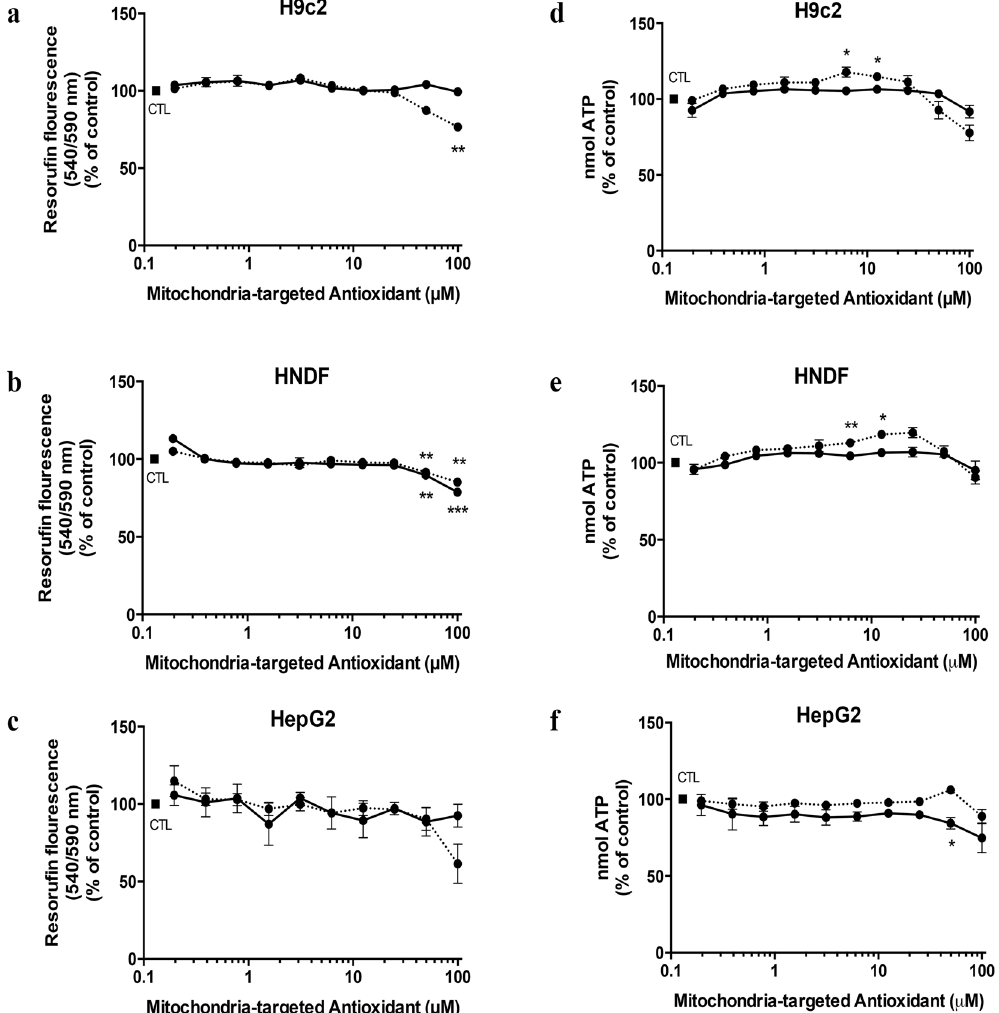
Figure 7. Cytotoxicity profile of AntiOxBEN 1 ( − ) and AntiOxBEN 2 ( − ) on ( a ) rat embryonic cardiomyoblasts (H9c2), ( b ) human neonatal dermal fibroblasts (HNDF) and ( c ) human hepatocellular carcinoma (HepG2) cells. AntiOxBEN 1 ( − ) and AntiOxBEN 2 ( − ) cytotoxicity determined by changes in intracellular ATP levels on ( d ) rat embryonic cardiomyoblasts (H9c2), ( e ) human neonatal dermal fibroblasts (HNDF) and ( f ) human hepatocellular carcinoma (HepG2) cells. Data are means ± SEM of four independent experiments and the results are expressed as percentage of control (control = 100%), which represents the cell density without any treatment in the respective time point. Statistically significant compared with control group using one-way ANOVA. Significance was accepted with * P < 0.05, ** P < 0.01, *** P < 0.0005, **** P <